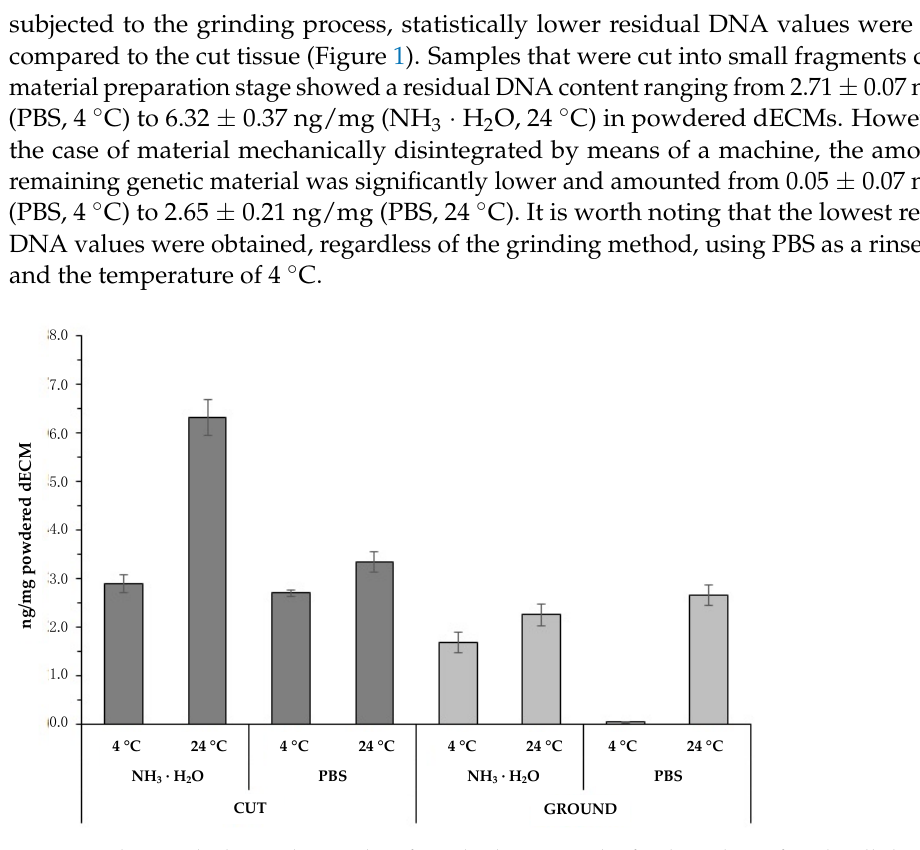
Figure 1. The graph shows the results of residual DNA in the final product after decellularization, lyophilization, and milling on a cryogenic mill. In the event of the grounded tissue, the PBS solution at 24 °C turned out to be the least effective. All other tests showed significantly lower residual DNA values. As in the case of the PBS solution, a significant decrease in DNA content was demonstrated for the NH 3 · H 2 O solution at 4 °C vs. 24 °C.